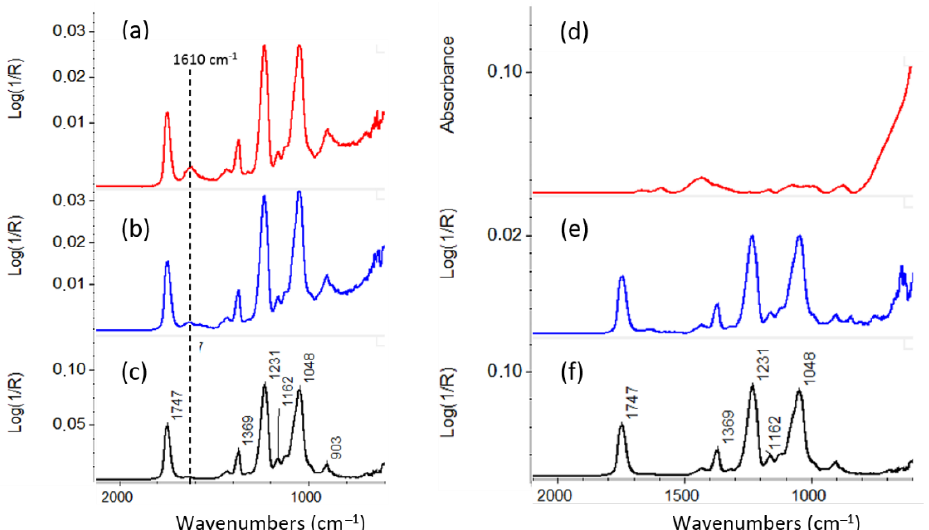
Figure 6. ATR-FTIR spectra of CA fibres. On the left: ( a ) with a 30 nm Al 2 O 3 (TMA + O 3 ) coating (red), ( b ) with a 30 nm Al 2 O 3 (TMA + H 2 O) ALD coating (blue), ( c ) uncoated (black). On the right: ( d ) ZnO as reference (red), IR-Library, HR-Minerals, Zincite ZnO, ( e ) 30 nm ZnO (blue) and ( f ) uncoated CA fibres.